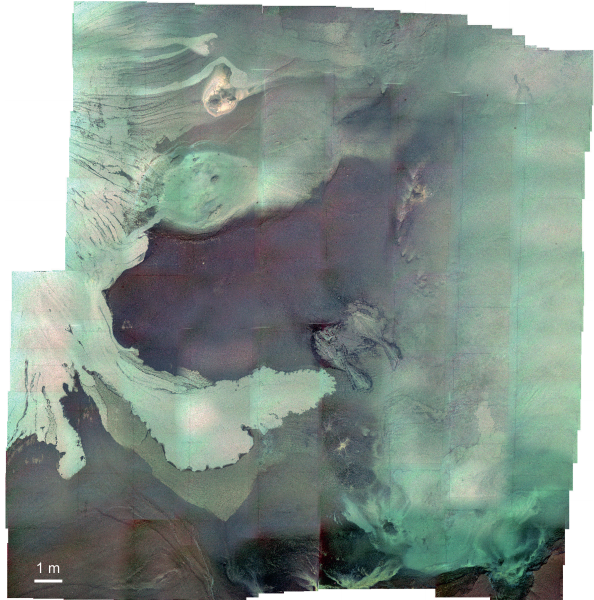
Fig. 11. Photo-mosaic showing mud pool and mud flows at the Hel- goland mud volcano; the mosaic was built with 218 images and covers an area of about 400m 2 .